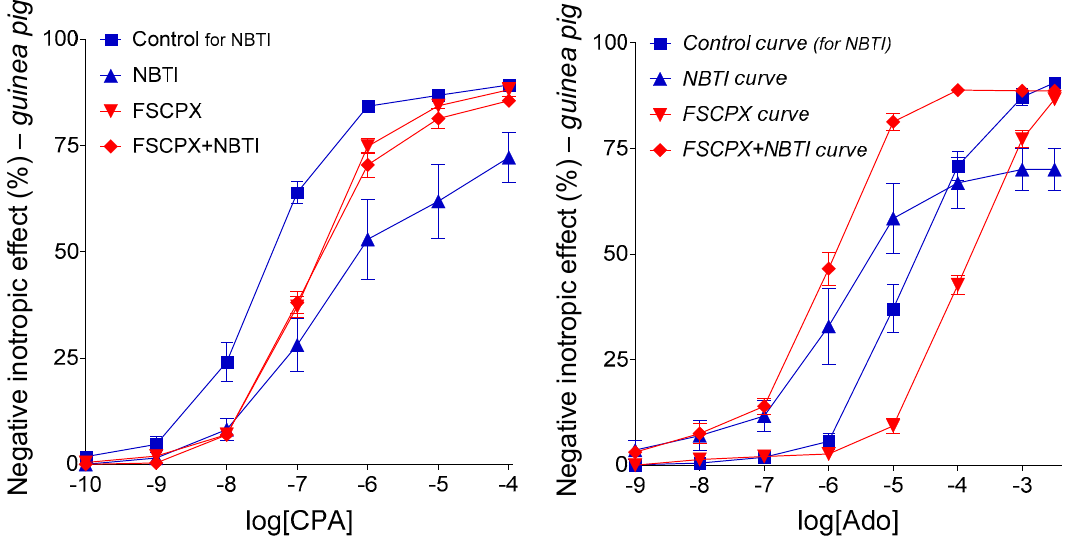
Figure 1. The direct negative inotropic effect of CPA ( left panel ), a synthetic full agonist of the A 1 adenosine receptor with a relatively long half-life [10], and adenosine ( right panel ), the physiological adenosine receptor full agonist with a short half-life [10] in the isolated guinea pig left atrium, with and without a pretreatment with FSCPX combined with the absence and presence of NBTI. The x -axis shows the common logarithm of the molar concentration of the given agonist (in the bathing medium), while the y -axis denotes the effect (determined as a percentage decrease in the initial contractile force). The symbols indicate the responses to the agonists averaged within the groups (±SEM). The blue and red E/c curves refer to the absence and presence of an FSCPX pretreatment, respectively. Group names are written with upright letters, while different E/c curves obtained from the same groups are indicated in italics. CPA: N 6 -cyclopentyladenosine; Ado: adenosine; FSCPX: 8-cyclopentyl- N 3 -[3-(4-(fluorosulfonyl)benzoyloxy)propyl]- N 1 -propylxanthine; NBTI: S -(2-hydroxy-5-nitrobenzyl)-6-thioinosine. Data are redrawn from [19].